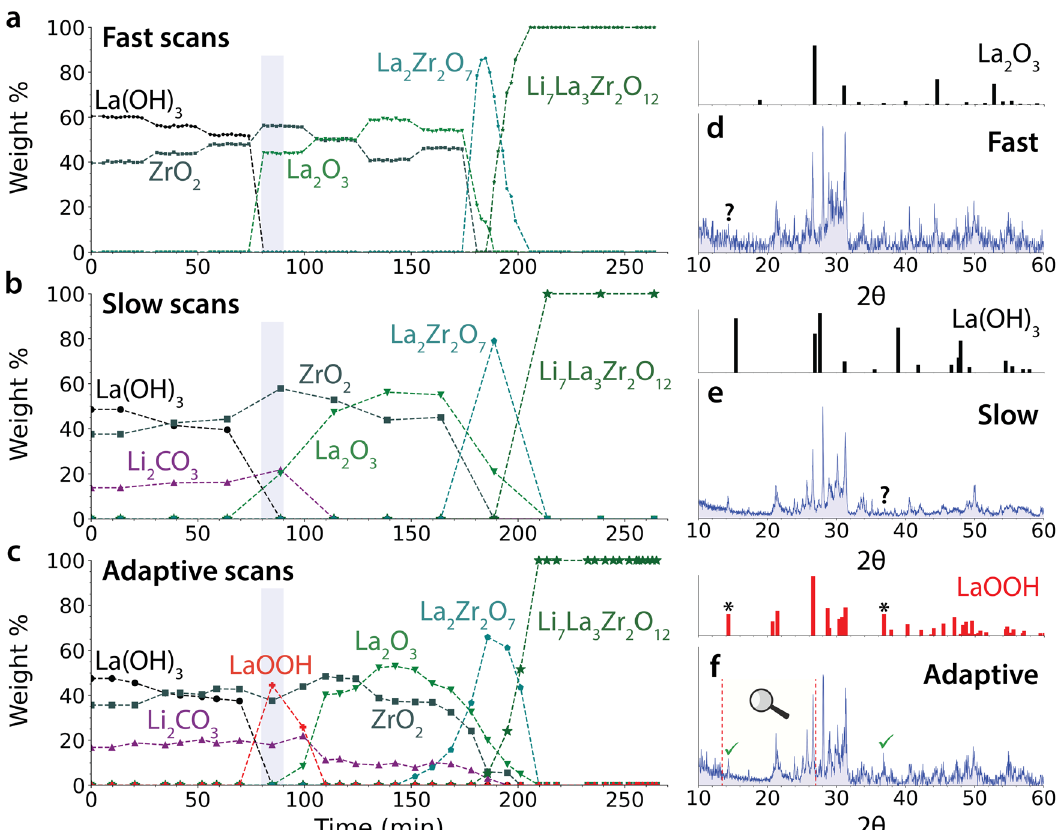
Fig. 4 In situ identi fi cation of phases formed during LLZO synthesis. The weight fractions are plotted separately for all phases detected from a fast 1 min scans, b slow 10 min scans, and c adaptive scans. A short-lived intermediate phase, LaOOH, is detected only with adaptive measurements. Panels d – f illustrate XRD patterns obtained from the blue highlighted regions in panels a – c , which each should contain LaOOH. d A fast scan misses low-2 θ peaks from this phase owing to a poor signal-to-noise ratio. e A slow scan misses high-2 θ peaks as LaOOH transforms before the measurement is complete. f An adaptive scan successfully detects all peaks from this phase by performing a rapid scan over [10°, 60°], followed by resampling of [14°, 27°] to clarify the smaller